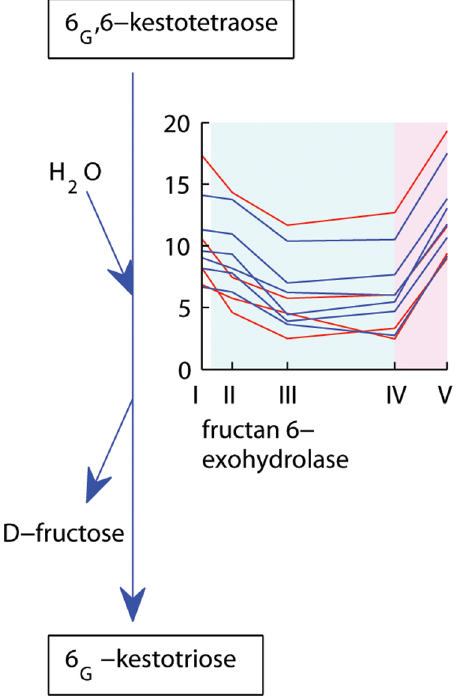
Figure 8. Expression profiles of Falster and Veyo transcripts involved in fructan degradation. Falster transcripts are depicted in blue, Veyo transcripts in red. The x axis presents the sample collection time points: I= autumn conditions, before the start of vernalization; II=2 days of vernalization; III=4 weeks of vernalization; IV=9 weeks of vernalization; V=7 days of long day conditions. The y axis corresponds to the variance stabilized data from DESeq. The blue background illustrates vernalization treatment, the pink background illustrates long day conditions. Figure adapted from the Plant Metabolic Pathways database (http://www.plantcyc.org/).